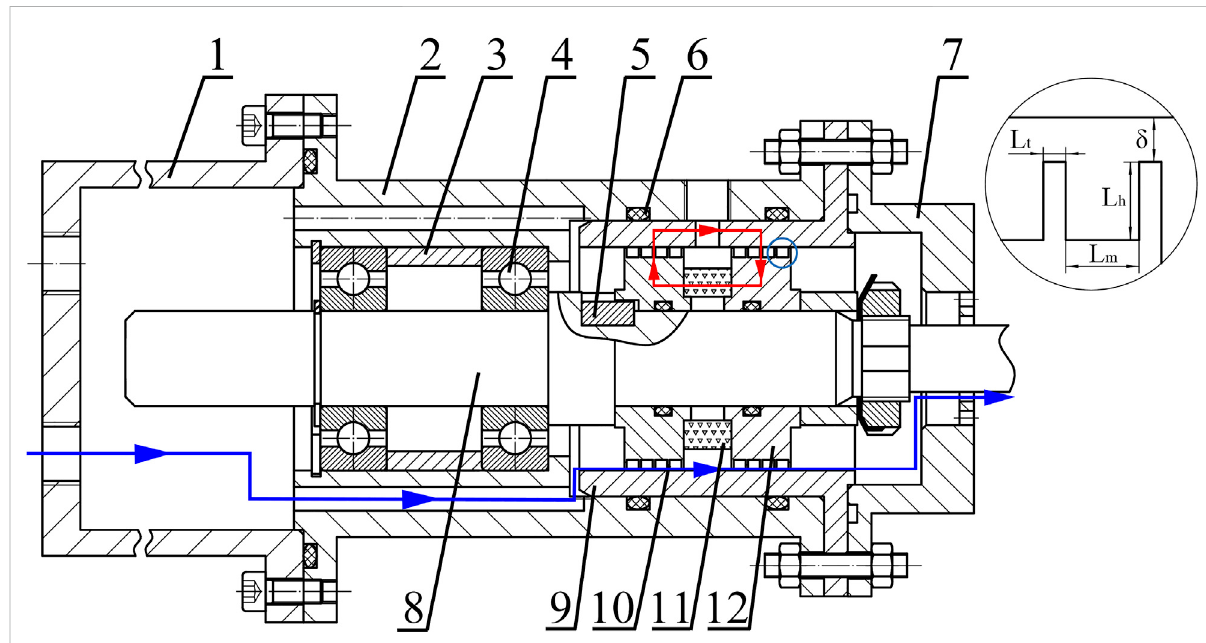
FIGURE 3 Schematicofthesealingprototype(1-gaschamber,2-shell,3-sleeve,4-bearing,5-key,6-rubberring,7-cover,8-shaft,9-innersleeve,10-pole tooth, 11-permanent magnet, 12-pole